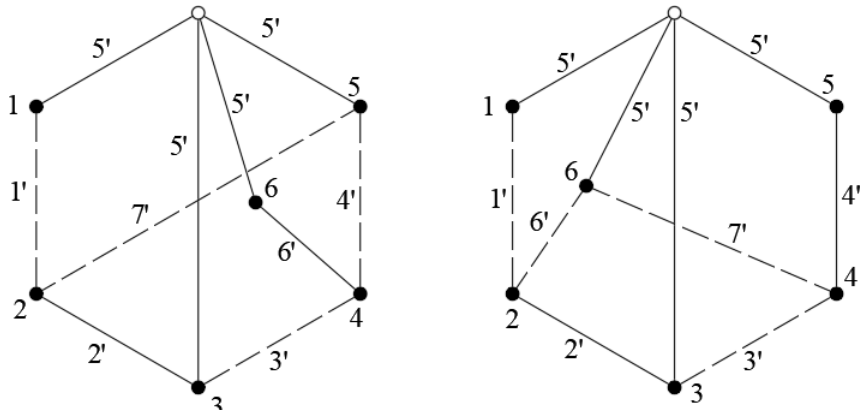
Figure 3. The topological graphs of 6-link EGTs a 1 and a 2 .